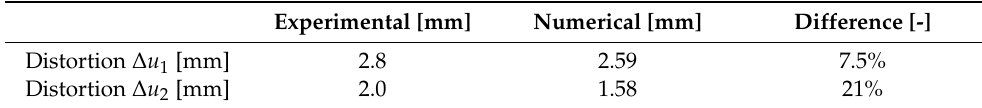
Figure 14. ( a ) Numerical vs. ( b ) experimental displacements at the end of the cooling phase at mid-section of the joint; numerical displacements in [mm]. Table 2. Residual distortion